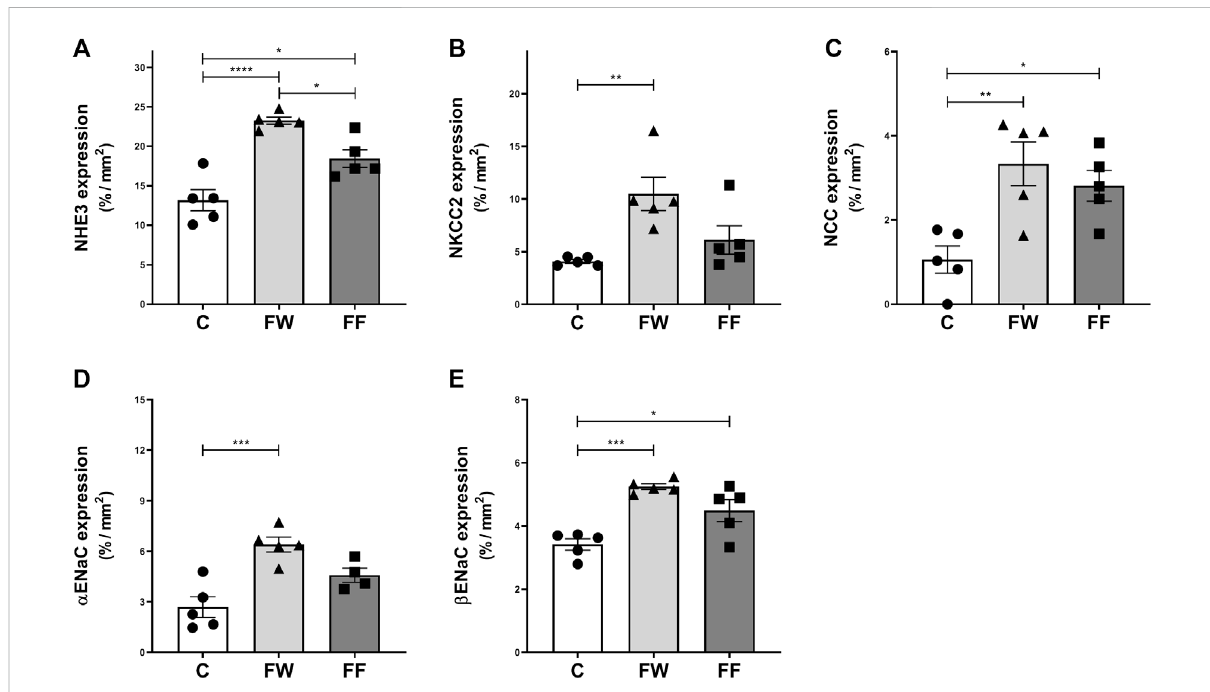
FIGURE 2 Expressions of renal sodium transporters: sodium-hydrogen exchanger 3 (NHE3) (A) , sodium-potassium-chloride cotransporter (NKCC2) (B) , sodium-chloride cotransporter (NCC) (C) , and epithelial sodium channel ( α and β ENaC) (D,E) . Signi fi cance level: ANOVA followed by Bonferroni; values are means ± standard error, 5 – 6 animals per group. * p ≤ 0.05; ** p ≤ 0.01; ***p ≤ 0.001; **** p ≤